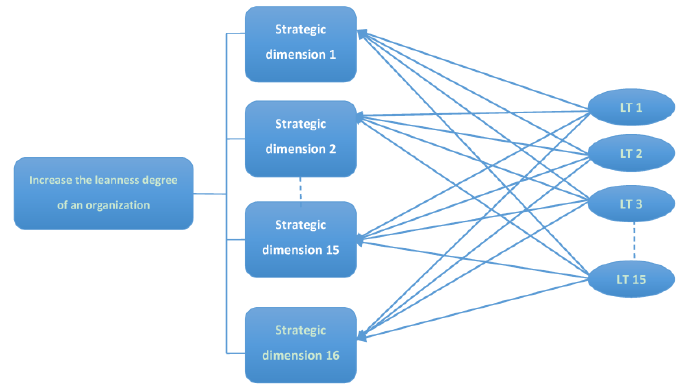
Figure 5. Hierarchic decomposition of the problem.